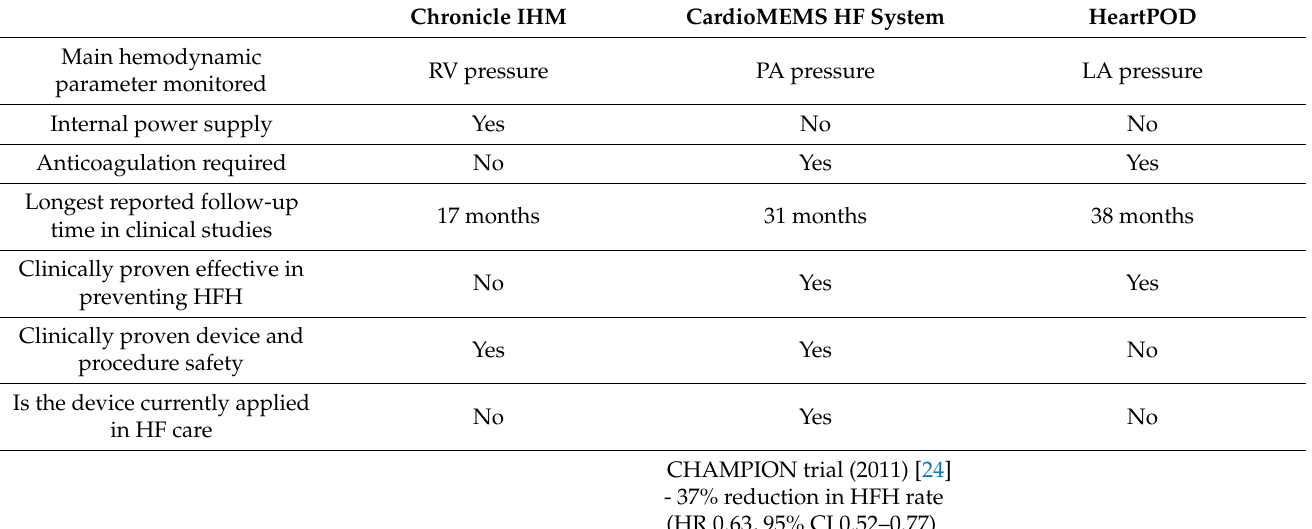
Table 1. Overview of main device characteristics and clinical evidence on efficacy and safety. IHM, implantable heart moni- tor; HF, heart failure; RV, right ventricular; PA, pulmonary artery; LA, left atrial; HFH, heart failure related hospitalizations; HR, hazard ratio; U.S., United States; U.K., United Kingdom; CI, confidence